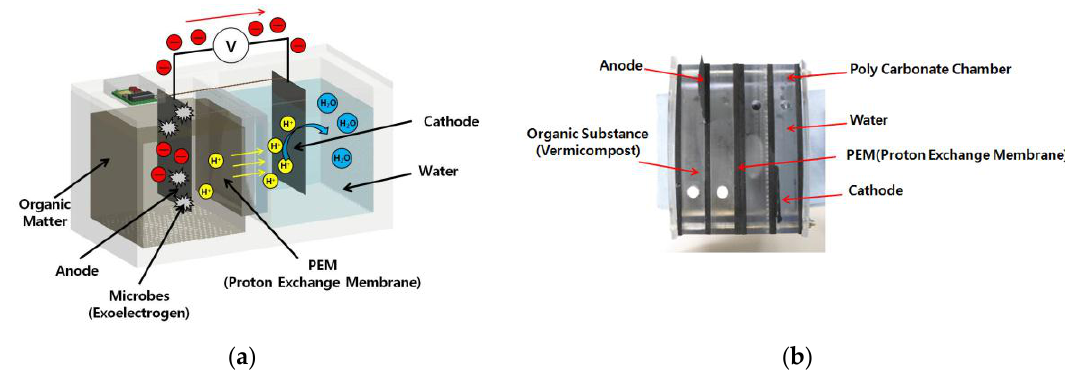
Figure 1. Batch-mode microbial fuel cell (MFC): ( a ) Working principle; ( b ) Developed prototype.